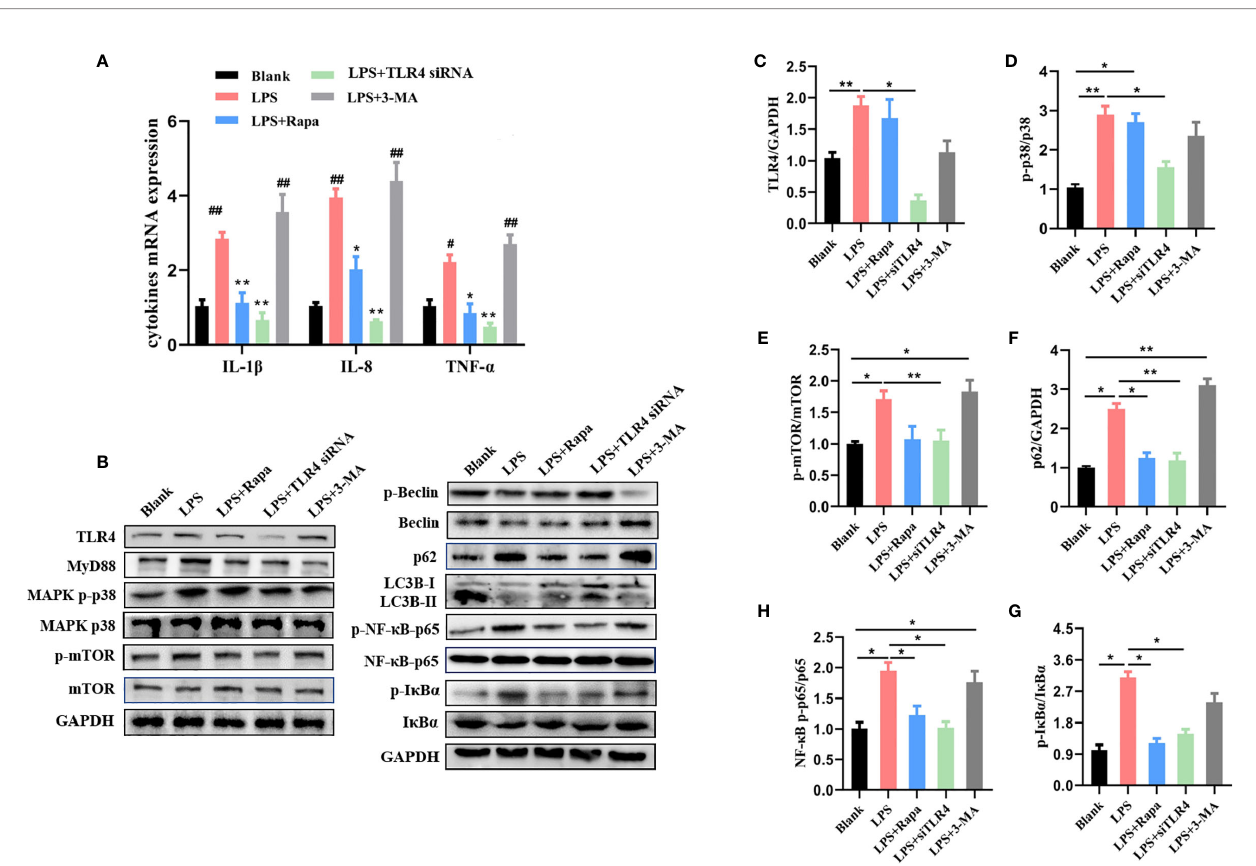
FIGURE 8 | Blocking upstream TLR4-MAPK pathway activated autophagy and quenched in fl ammation. (A) Changes of cytokines contents in different groups in LPS-induced HT-29 cells. (B) The changes of autophagy-related and in fl ammation-related proteins measured by western blot. (C – H) The expressions of proteins were quanti fi ed by the ratio of phosphorylated protein/total protein and total amount protein/GAPDH. All data shown are representative of 3 independent experiments. Bars in graphs represent mean ± SD, *P < 0.05, **P < 0.01. # P < 0.05, ## P < 0.01 VS Control